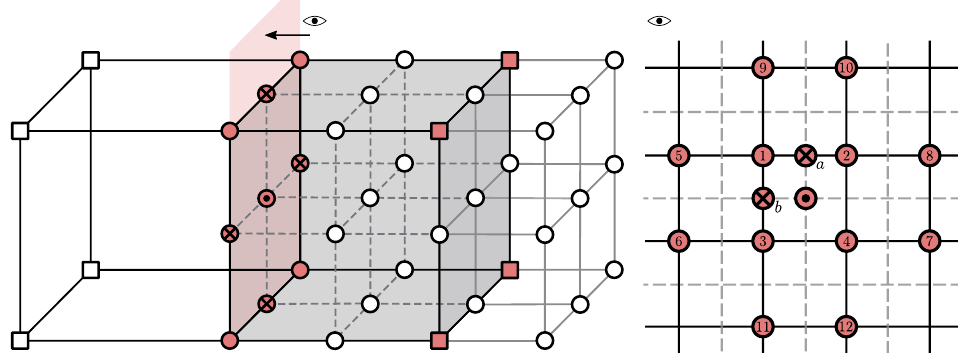
Figure 4. ( Left ): Grid transition interface for three-dimensional cell-vertex layout, : regular fine node, : co-located fine and coarse nodes at fine interface, : hanging middle node, • : hanging center node, : regular coarse node, : co-located fine and coarse nodes at coarse interface. ( Right ): Stencil for hanging node